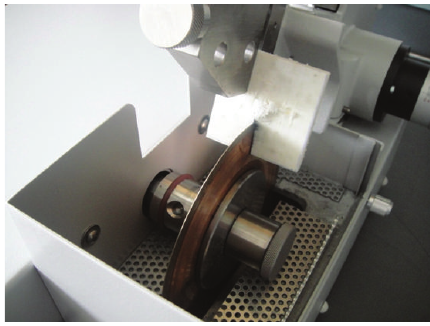
Figure 2: A high precision saw cutting the composite sample in the mid plane where the damage zone is present.